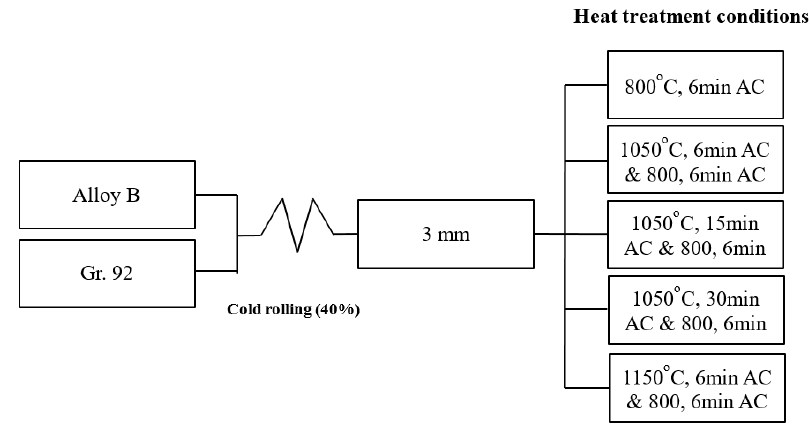
Figure 1. Schematic of the experimental procedure. AC: air cooling.